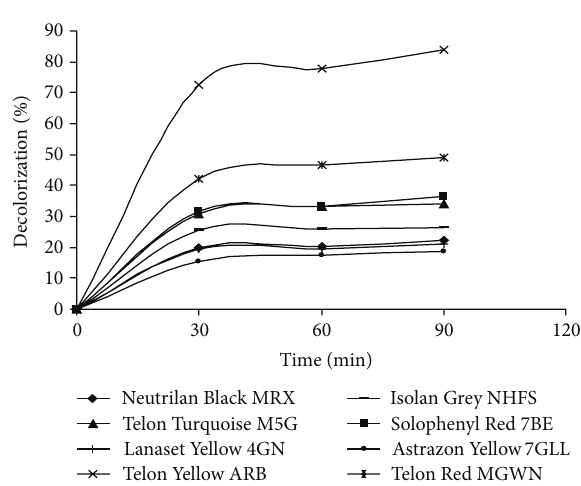
Figure 3: Removal of eight dyes by immobilized quince leaf